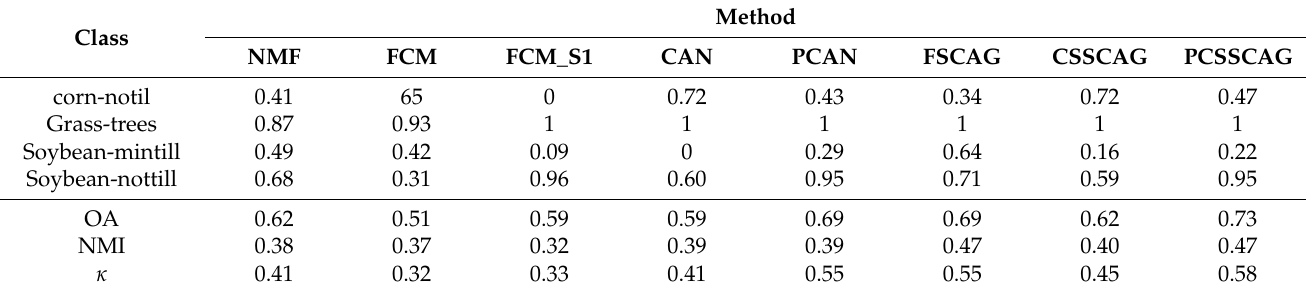
Table 1. Clustering accuracy of each category, OA, NMI, and κ of different clustering methods on Indian Pines dataset.